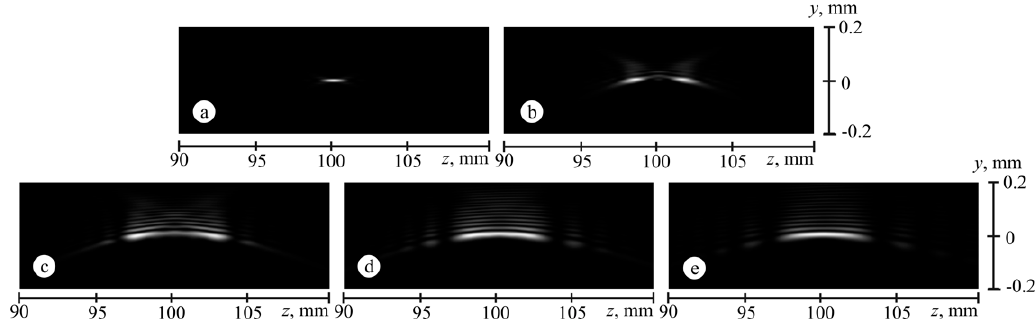
Figure 2. PSF longitudinal pattern with a CoC size limit of 0.02 mm ( z ∈ [90 mm; 110 mm], y ∈ [ − 0.2 mm; 0.2 mm]) for a lens without apodization ( a ) and with asymmetric phase apodization n = 2, α = 0.00025 ( b ); n = 3, α = 0.00045 ( c ); n = 4, α = 0.00054 ( d ); and n = 5, α = 0.00081 ( e ), with the wavelength of the illuminating beam λ = 550 nm.